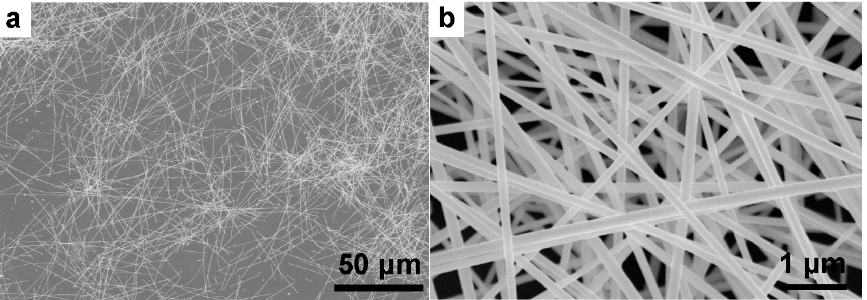
Figure 1. SEM images of the as-prepared Ag nanowires at different magnification: ( a ) low-magnification, ( b ) high-magnification.